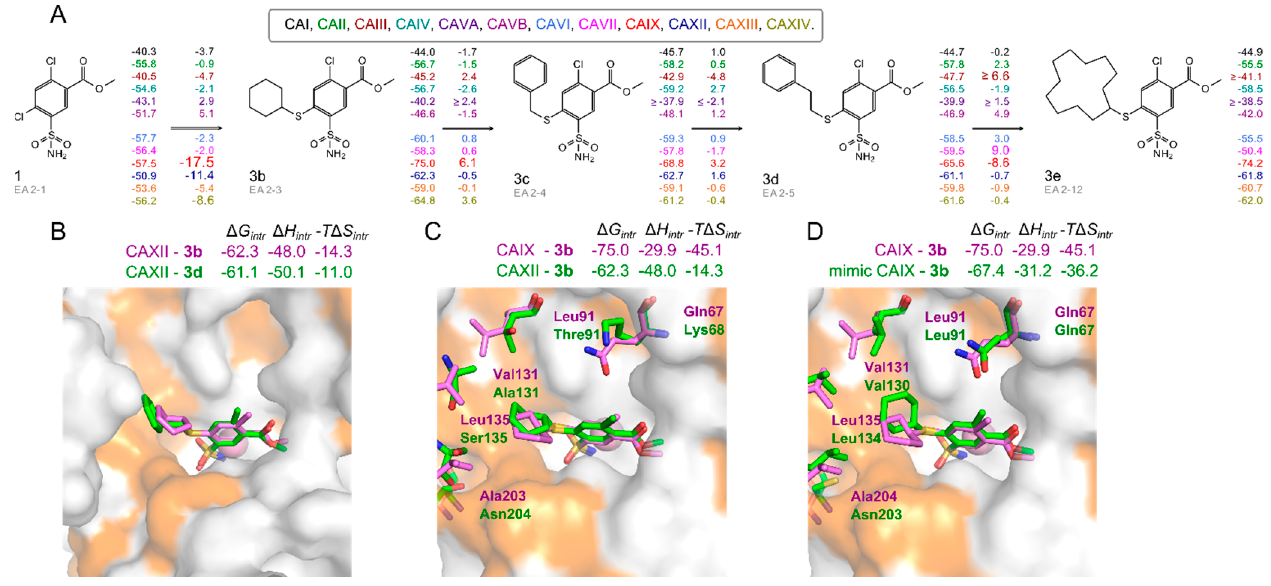
Figure 2. Correlation of compound chemical structures with the changes in standard intrinsic Gibbs energy upon binding and the comparison of the crystal structures between CA isozymes. ( A ) Differences of ∆ G intr between neighboring compounds are listed on the connecting arrows. All values have units of kJ/mol. Colors represent CA isozymes. ( B ) Compounds 3b (magenta, PDB ID: 7PP9) and 3d (green, PDB ID: 7PUW) bound to CAXII. ( C ) Compound 3b bound to CAXII (green, PDB ID: 7PP9) and CAIX (magenta, PDB ID: 7POM). ( D ) Compound 3b bound to CAIX (magenta, PDB ID: 7POM) and mimic-CAIX (green, PDB ID: 7Q0C). Zinc ion is shown as a pink sphere. The notable nonconservative residues between active sites are shown in the “stick” mode. The protein surface of the CA active site is colored orange for hydrophobic residues (V, I, L, F, M, A, G, and P) and gray for the residues with charged and polar side chains (R, D, N, E, Q, H, K, S, T, Y, W, and